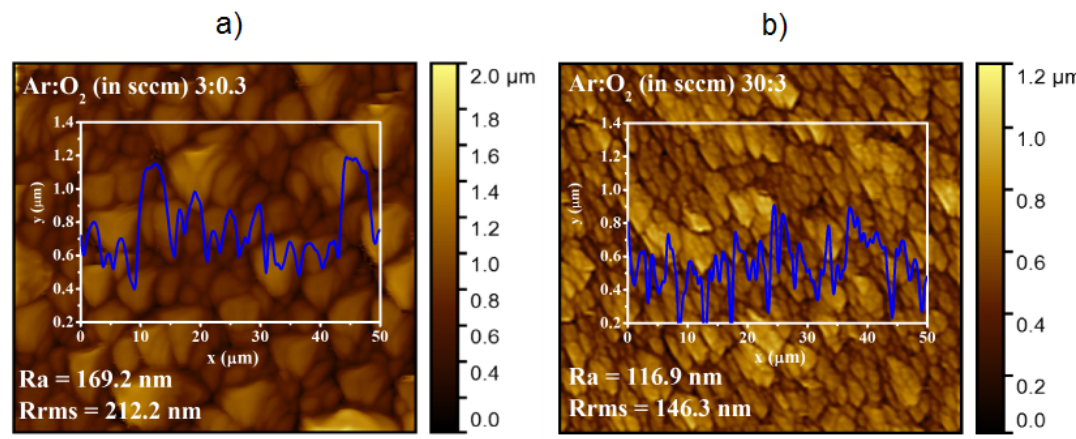
Figure 1. AFM images of nanostructured ZnO thin films deposited at the Ar/O 2 gas flow of 3:0.3 ( a ) and 30:3 ( b ), respectively (in sccm); R a denotes arithmetical mean deviation of the assessed profile, whereas R rms is a root mean square roughness parameter.